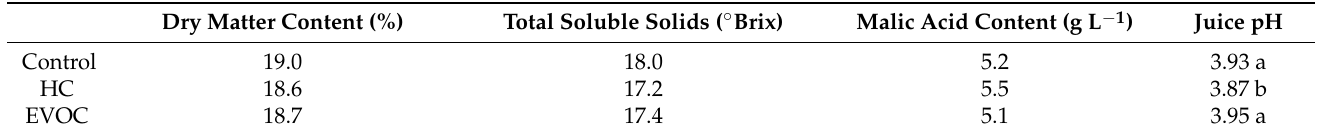
Table 7. Effect of dormancy-breaking agents on the fruit dry matter content, total soluble solids, malic acid content and juice pH of the sweet cherry cultivar ‘Lapins’. HC = hydrogen cyanamide; EVOC = emulsified vegetable oil compound.